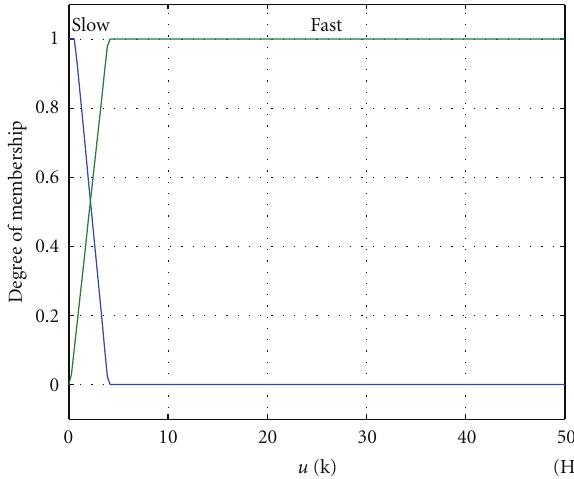
Figure 5: Membership function of the delivered frequency.